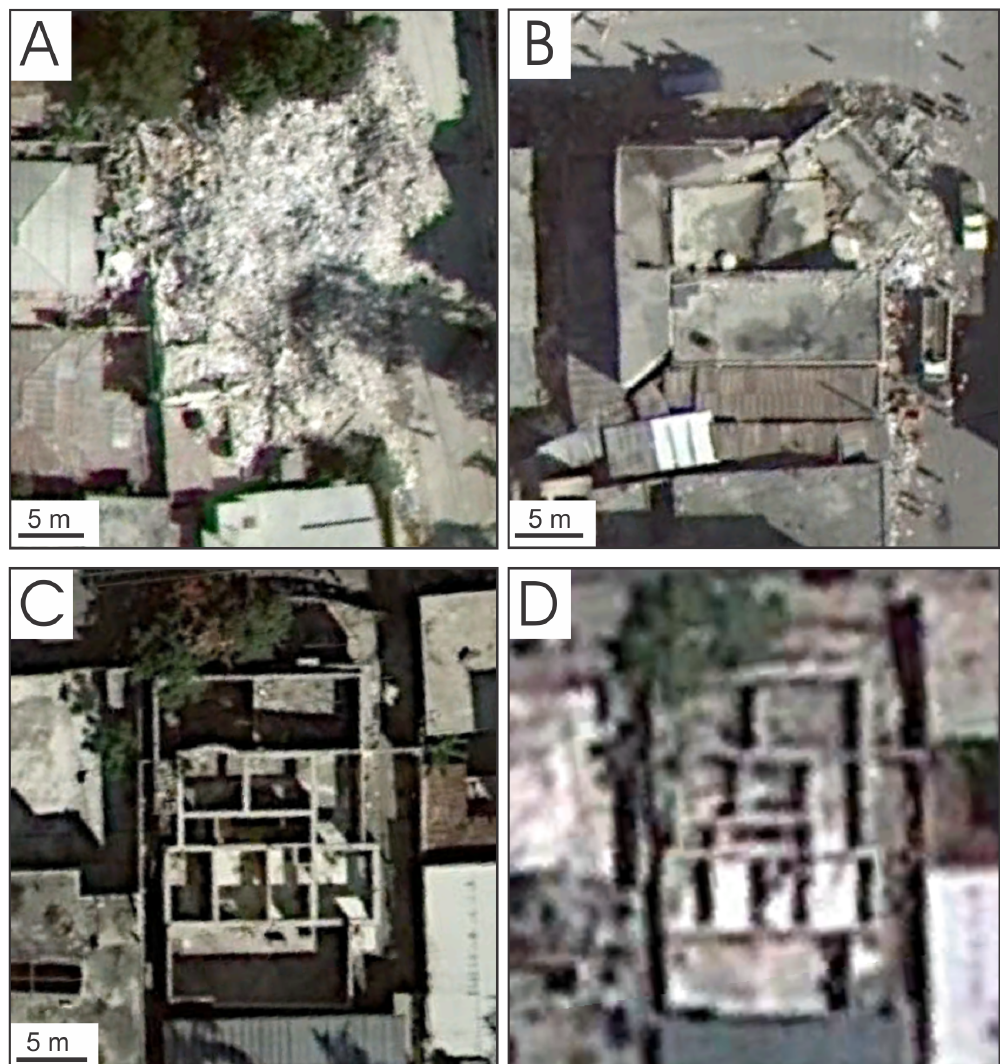
Fig. 4. Examples of different types of structural damage and their appearance in vertical image data in Port-au-Prince, Haiti. Rubble pile after disintegration of an adobe building (A) , and severe structural damage of a reinforced concrete structure ( B ; aerial photographs from 25 January 2010). Both are examples of D5 damage (total destruction) on the EMS98 scale. Many structures in Port-au-Prince were already strongly decayed by the time of the earthquake, or had never been finished, which is easily mistaken for damage. The building in (C) and (D) (pre- and post-disaster Geoeye-1 satellite images of 26 August 2009 and 13 January 2010, respectively) is an example. ©Google